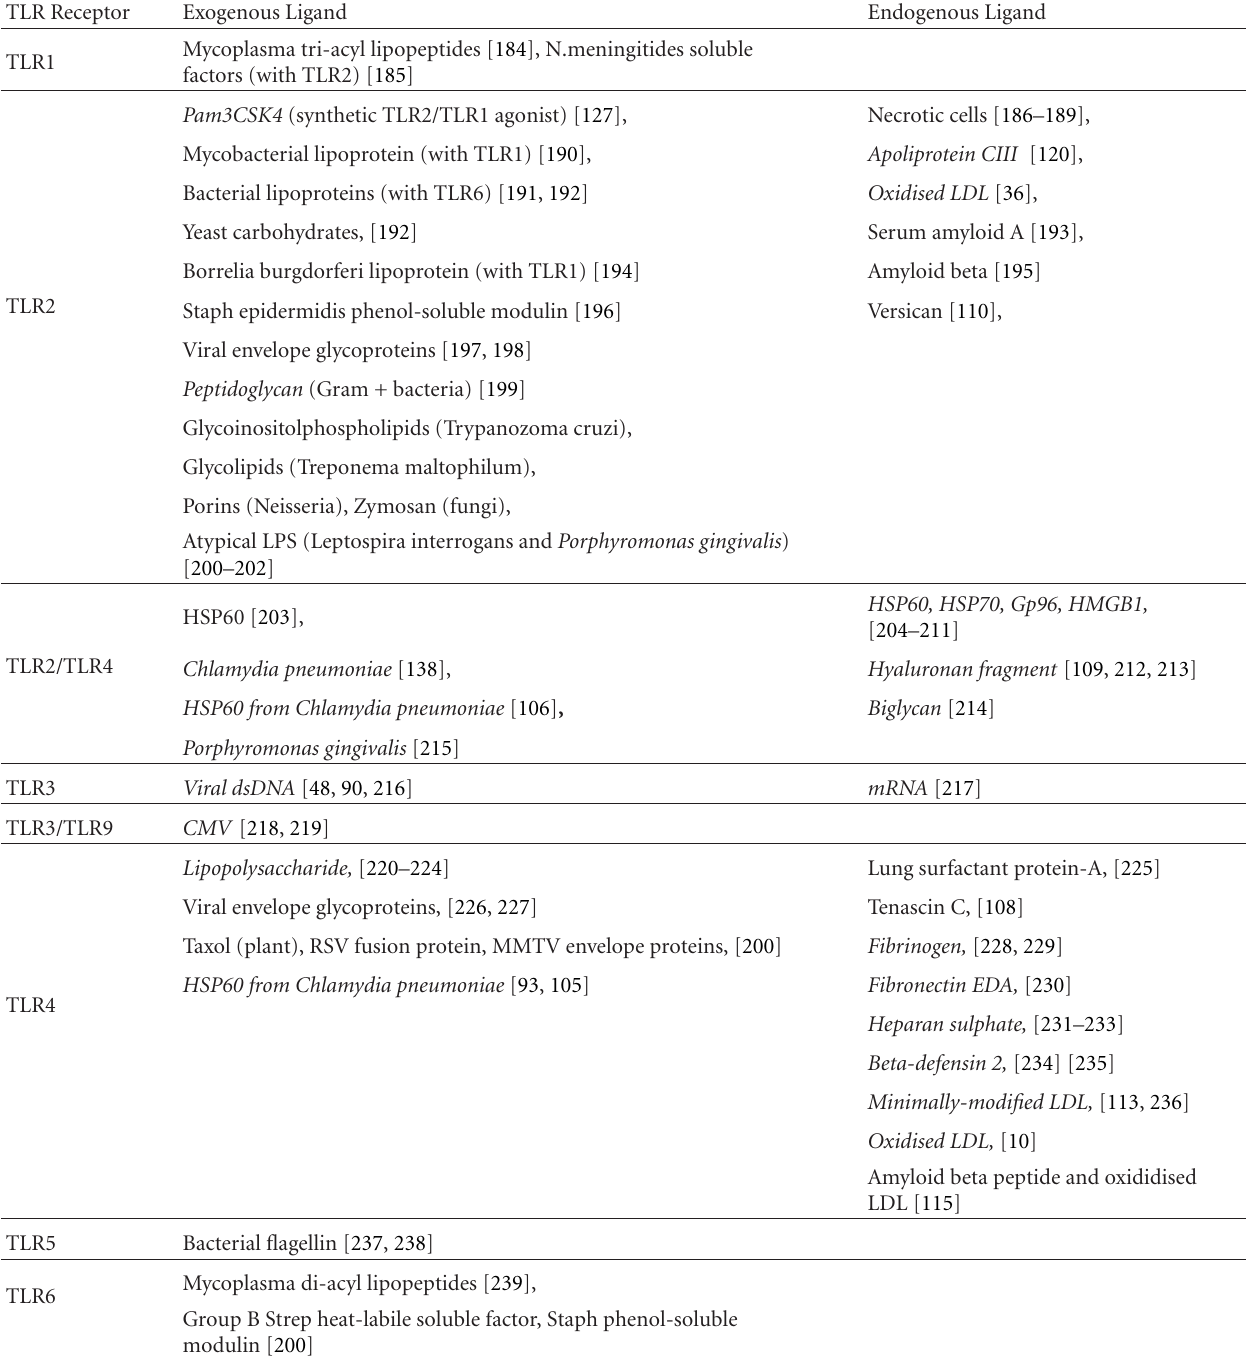
Table 1: Exogenous and Endogenous TLR ligands. Ligands in italics represent ligands for which a link to atherosclerosis has been identified. TLR